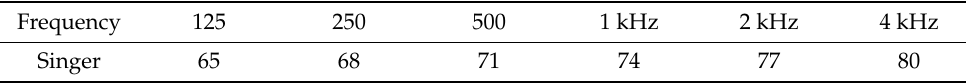
Table 6. Frequency data used for sound source (Marshall and Meyer